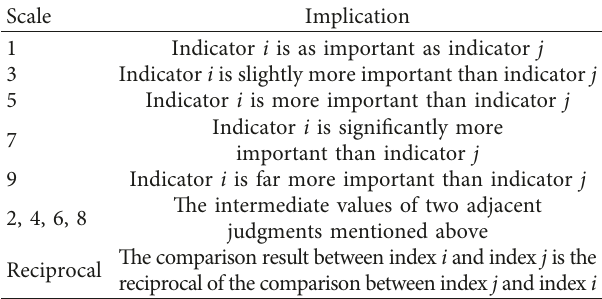
Table 2: Implication of index evaluation